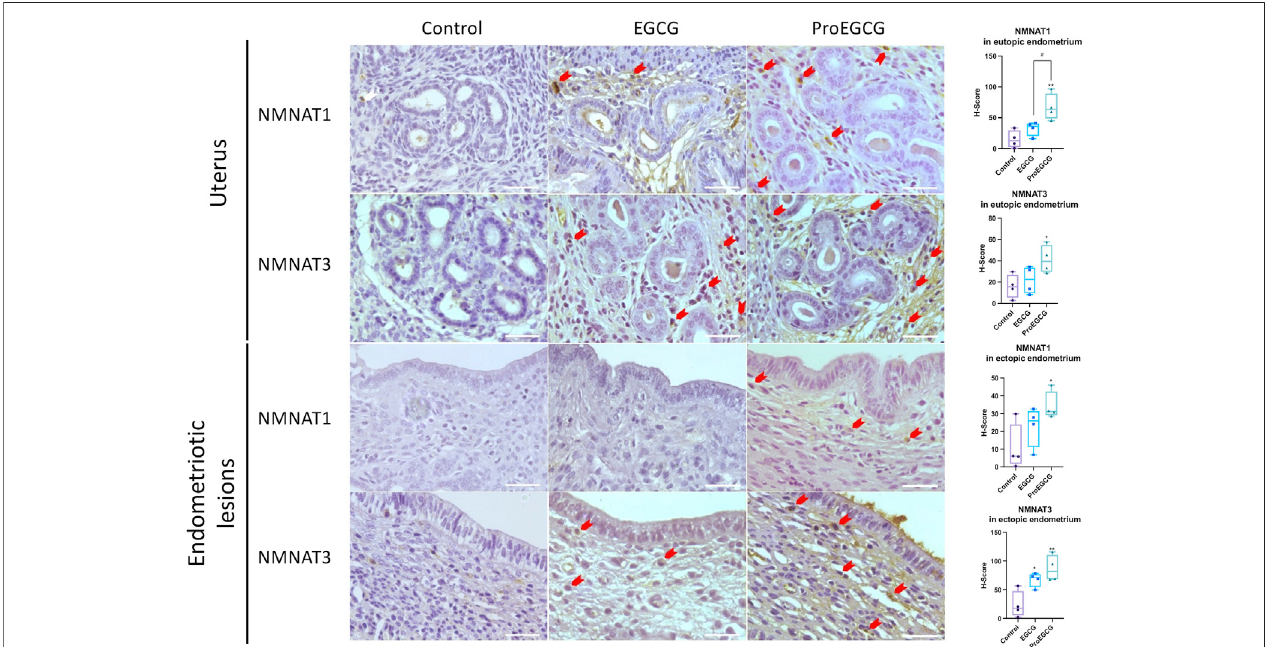
FIGURE6| ProteinexpressionsofNMNAT1andNMNAT3inuterusandendometrioticlesionsofEGCGandProEGCG-treatedanduntreatedgroups,determined byimmunohistochemistry.Representativeimagesindifferentgroupsareshown,redarrowdenotedpositivesstainingcells.TheH-scoreforNMNATsexpressioninmice eutopic and ectopic endometrial tissues were compared by whisker plot ( n (cid:1) 4). Top and bottom box edges represented the third and fi rst quartile. The whisker represented highest and lowest score. There median were shown as the verticle line inside the box. One-way ANOVA with Tukey post-hoc test was used for the multiple group ’ s comparison. * p < 0.05, ** p < 0.01, compared to control # p < 0.05 compared to only EGCG/ProEGCG. Scale bar (cid:1) 50